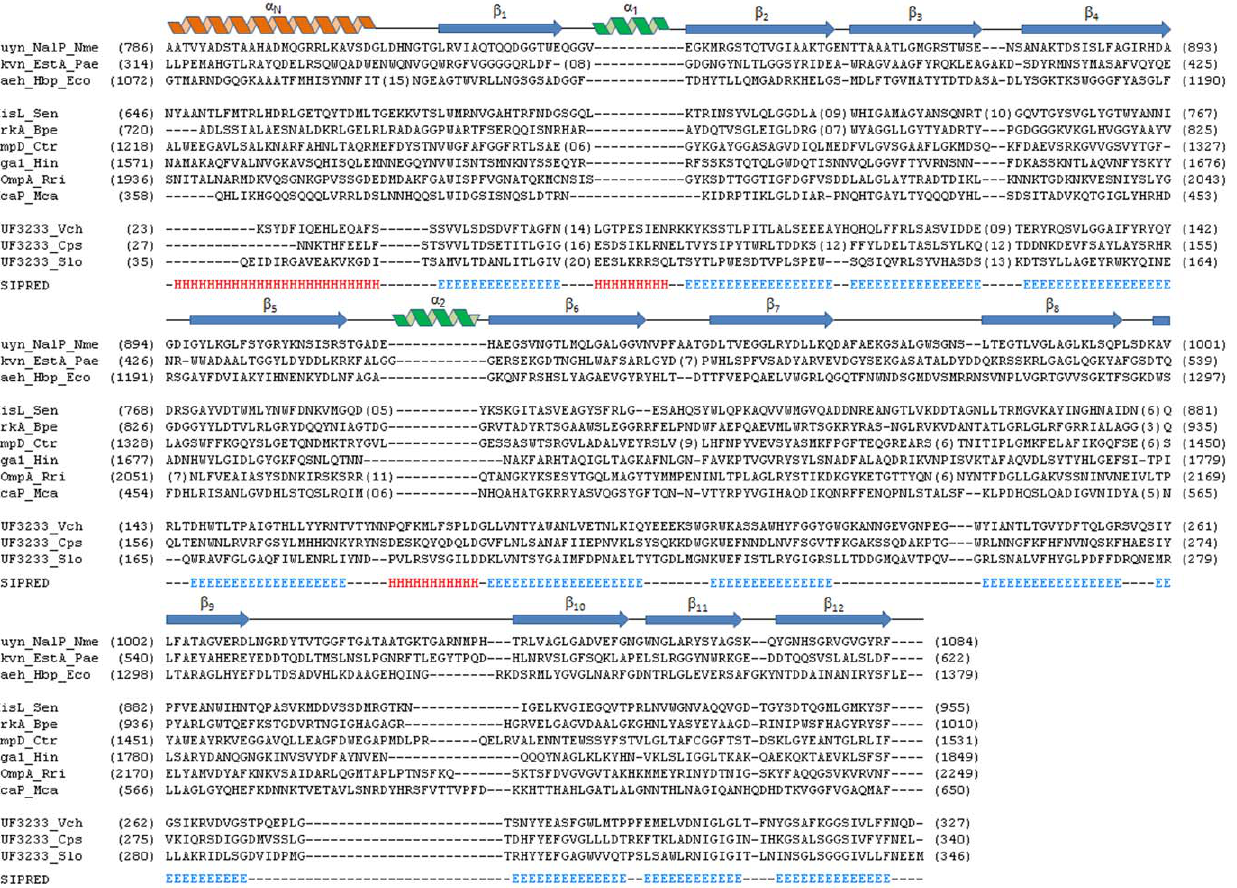
Figure 2. Sequence alignment of DUF3233 and translocation units of select autotransporters. Secondary structure diagram for NalP is shown at the top. The two extra helices ( a 1 and a 2 ) present among DUF3233 proteins are shown in green. DUF3233 and autotransporter sequences representing each cluster are used in the alignment. Nme_ Neisseria meningitidis , Pae_ Pseudomonas aeruginosa , Eco_ Escherichia coli , Sen_ Salmonella enterica , Bpe_ Bordetella pertussis , Ctr_ Chlamydia trachomatis , Hin_ Haemophilus influenzae , Rri_ Rickettsia rickettsii , Mca_ Moraxella catarrhalis , Vch_ Vibrio cholerae , Cps_ Colwellia psychrerythraea , Slo_ Shewanella loihica .